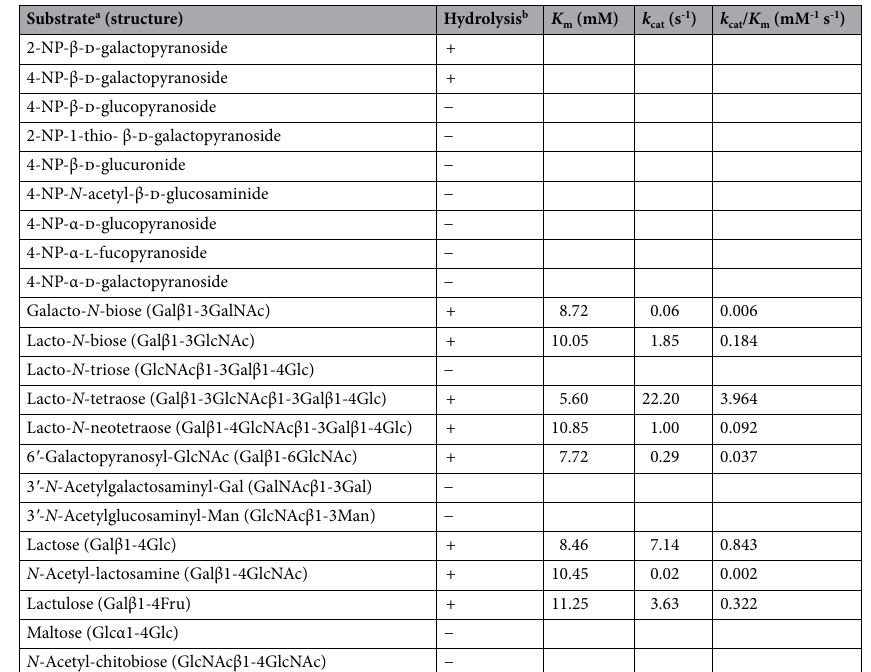
Table 3. Activity of enzyme Bdg42A. a Carbohydrates used as substrates. NP nitrophenyl, Glc glucose, Gal Galactose, GlcNAc N -acetylglucosamine, GalNAc N -acetylgalactosamine, Man , mannose, Fru fructose. b +, substrate is totally hydrolyzed after 16 h reaction in the conditions described in “Methods”; − , no activity detected.